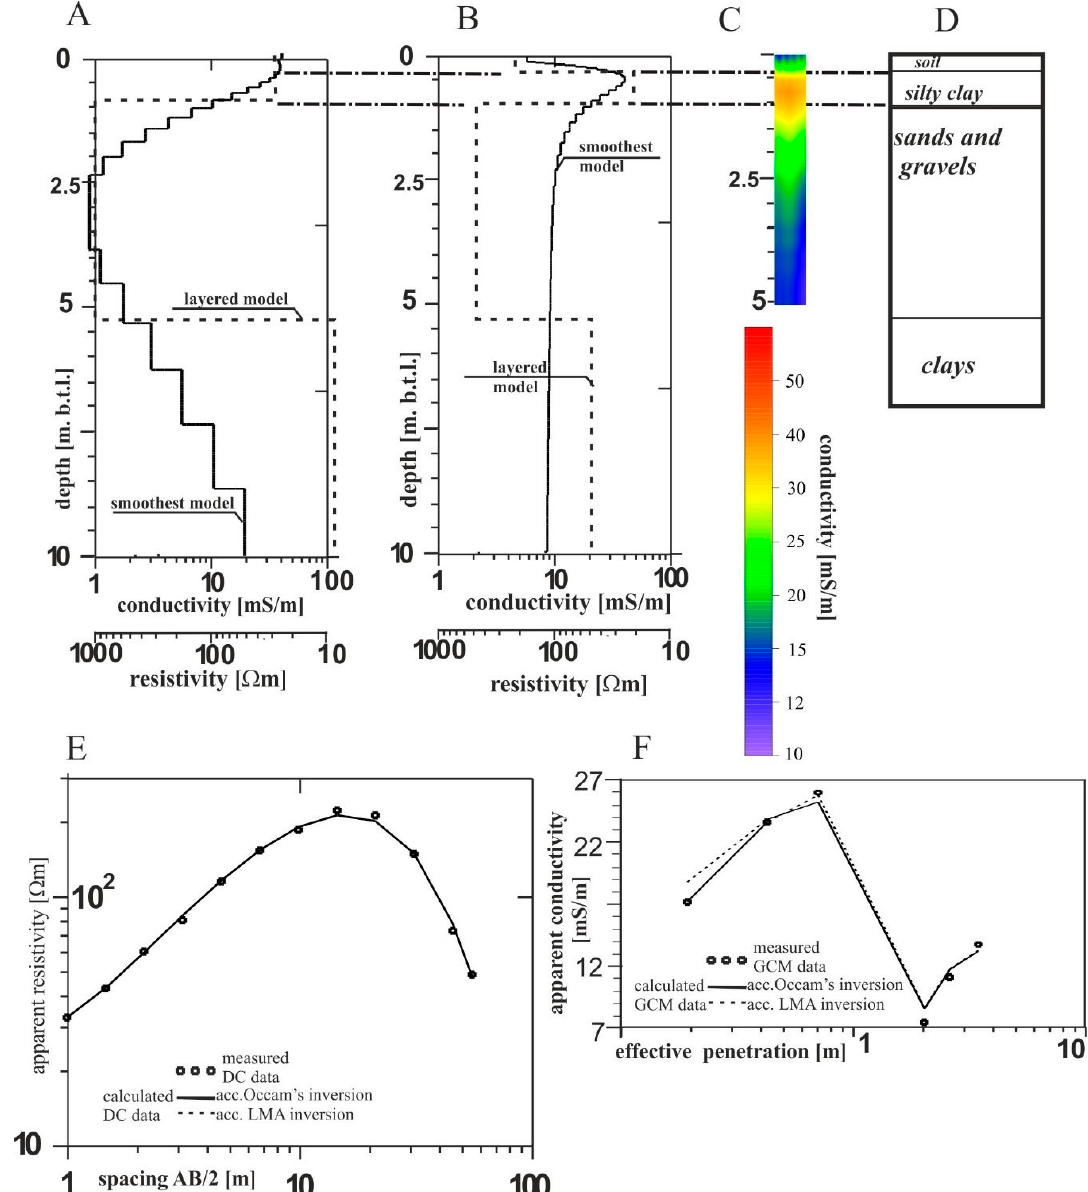
Figure 4. Results of an interpretation of location No. 1 (Figure 1) incorporating both the DC and GCM soundings and using IX1D software, A —geoelectric models obtained from the DC resistivity soundings, B —conductivity section of the DC data (for short array profiling), C —geoelectric models obtained from the GCM soundings, D —conductivity section of the GCM data (for short array profiling), E —borehole data, F —fit between the measured DC data and calculated DC data, G —fit between the measured GCM data and calculated GCM data. Correlation of the silty clay layer identified by the DC sounding and GCM sounding No. 1 (